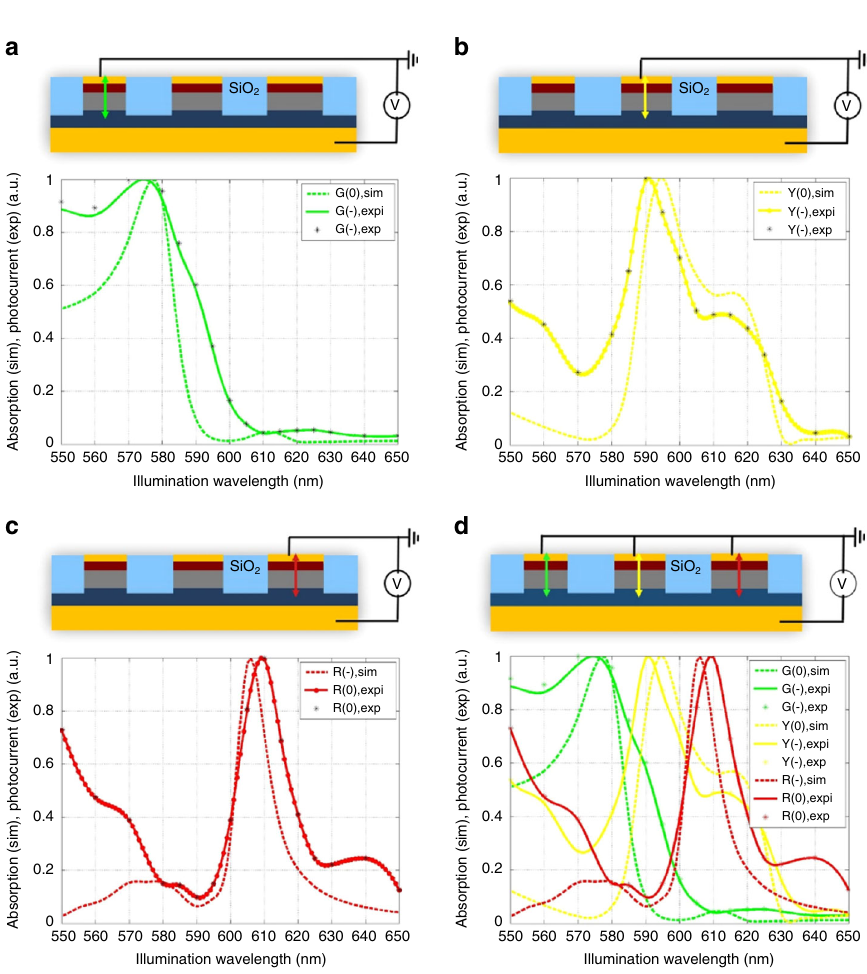
Fig. 3 Experimental three-channel color-sorting in anti-Hermitian PIN Si metasurface. Experimental photocurrent (solid curves) and simulated absorption (dashed curves) spectra of the AH PIN Si metasurface when electrical connection is made to a green, b yellow, and c red color channels. For clarity, all curves are normalized to their peak values. d Combined photocurrent and absorption spectra of all three channels. Legend labels “ sim ” , “ expi ” , and “ exp ” refer to simulated, interpolated experimental, and raw experimental data, respectively. Source data for a – d are provided in the Source Data File tabs labeled a – c , respectively.